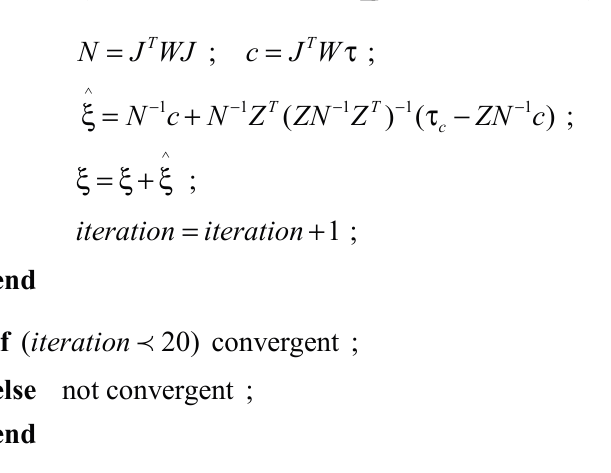
Figure 4. Iterative process of nonlinear least squares adjustment with